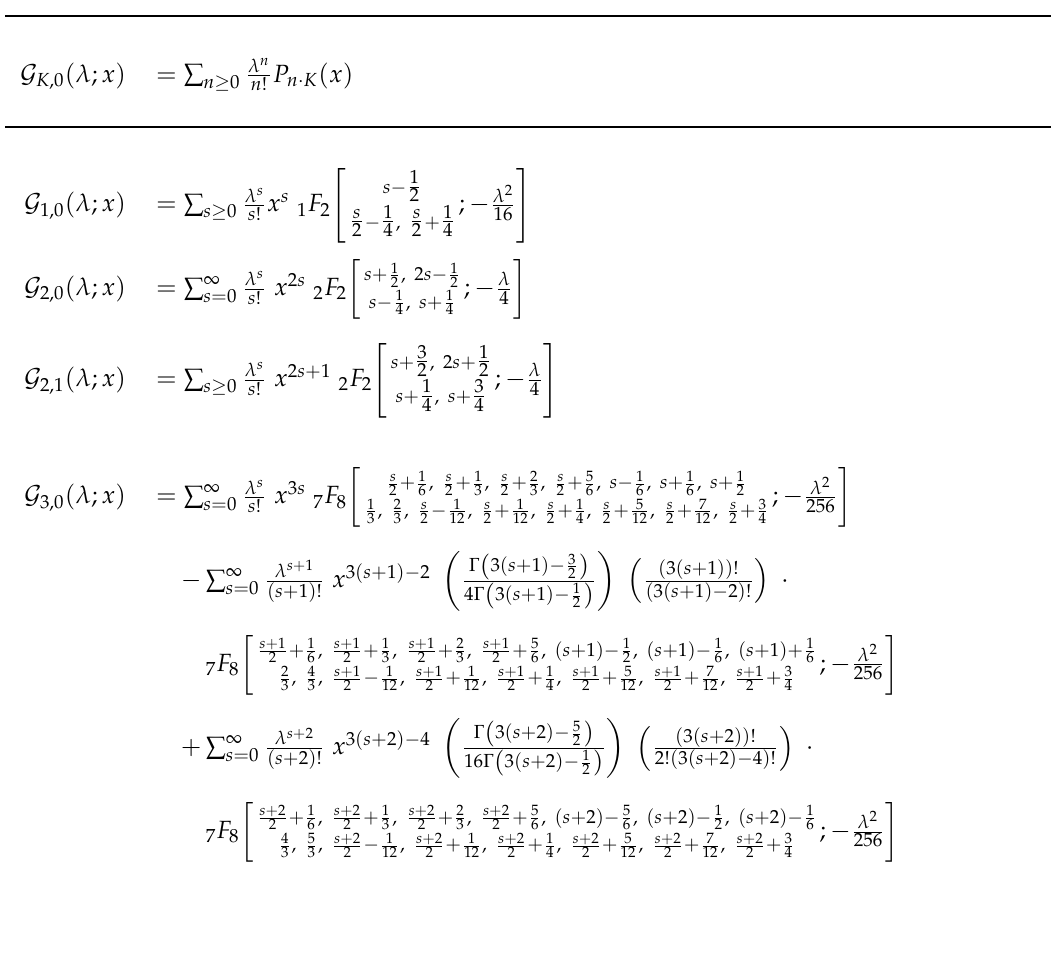
Table A2. Lacunary generating functions G K , L ( λ ; x ) for the SJ polynomials P n ( x ) and K = 1, . . . ,5 and some selected values of L ∈ Z ≥ 0 .